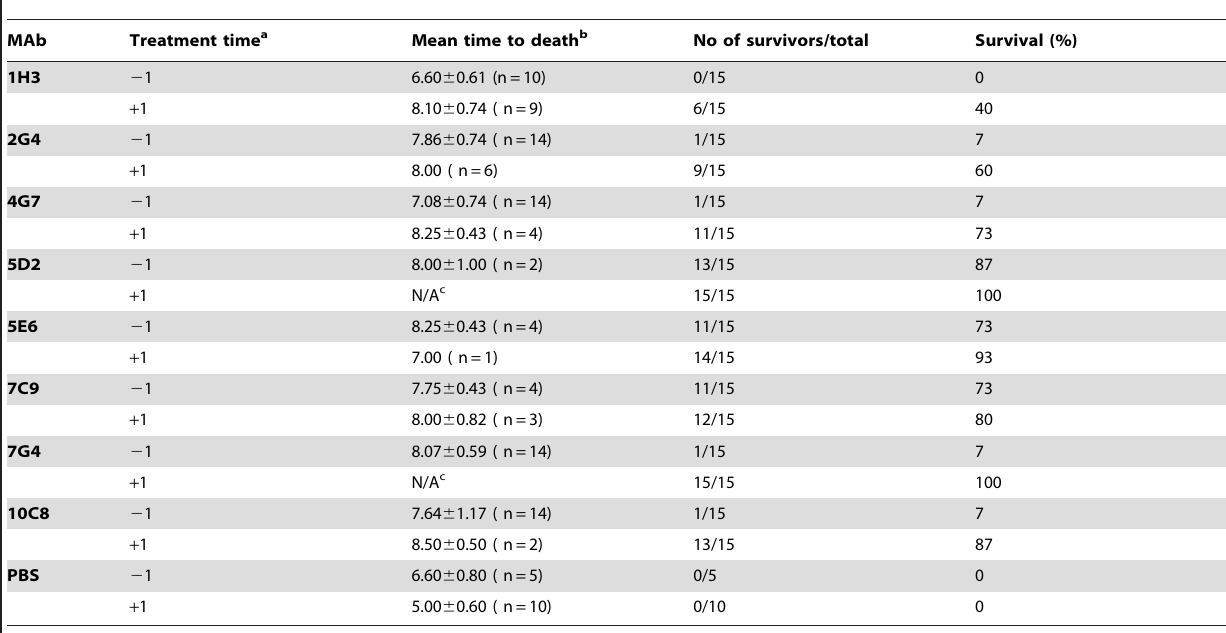
Table 1. Protective efficacy of MAbs in